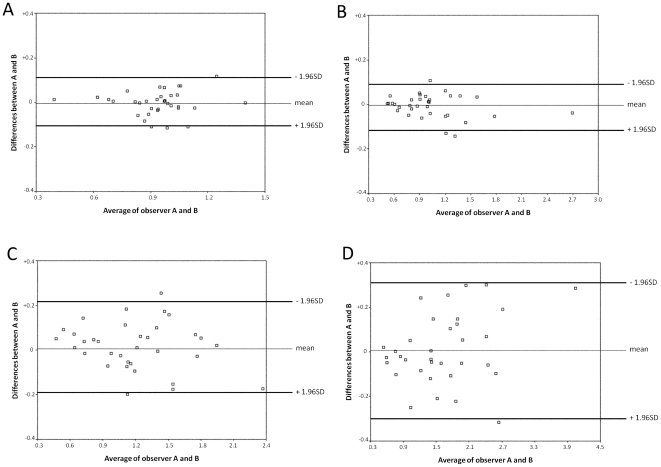
Bland-Altman plots for measurements of T2-GRE (A), T2-EPI (B), DW-EPI-500 (C), and DW-EPI-1000 (D) in liver parenchyma.Each Bland-Altman plots demonstrates good interobserver agreement and lack of proportional bias or fixed bias. The average of the measurements made by the two observers is plotted against the difference between the measurements made by the two observers. The thin lines represent the mean value of all differences between the two observers, and the thick lines represent the 95% limits of agreement. SD = standard deviation.